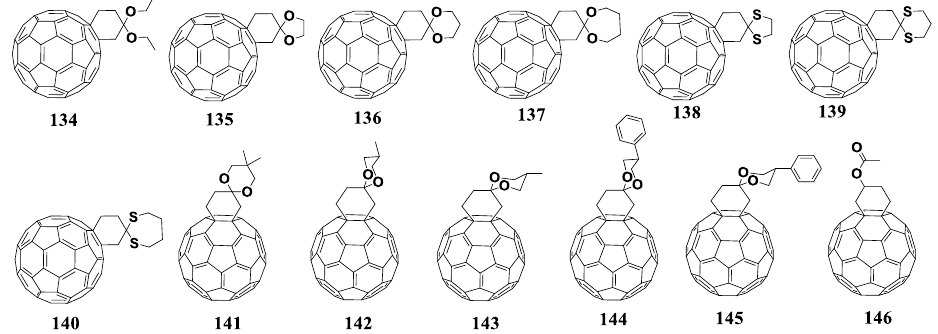
Figure 15. Molecular structures of cyclohexane fullerene C 60 adducts with reduced electron affinity.